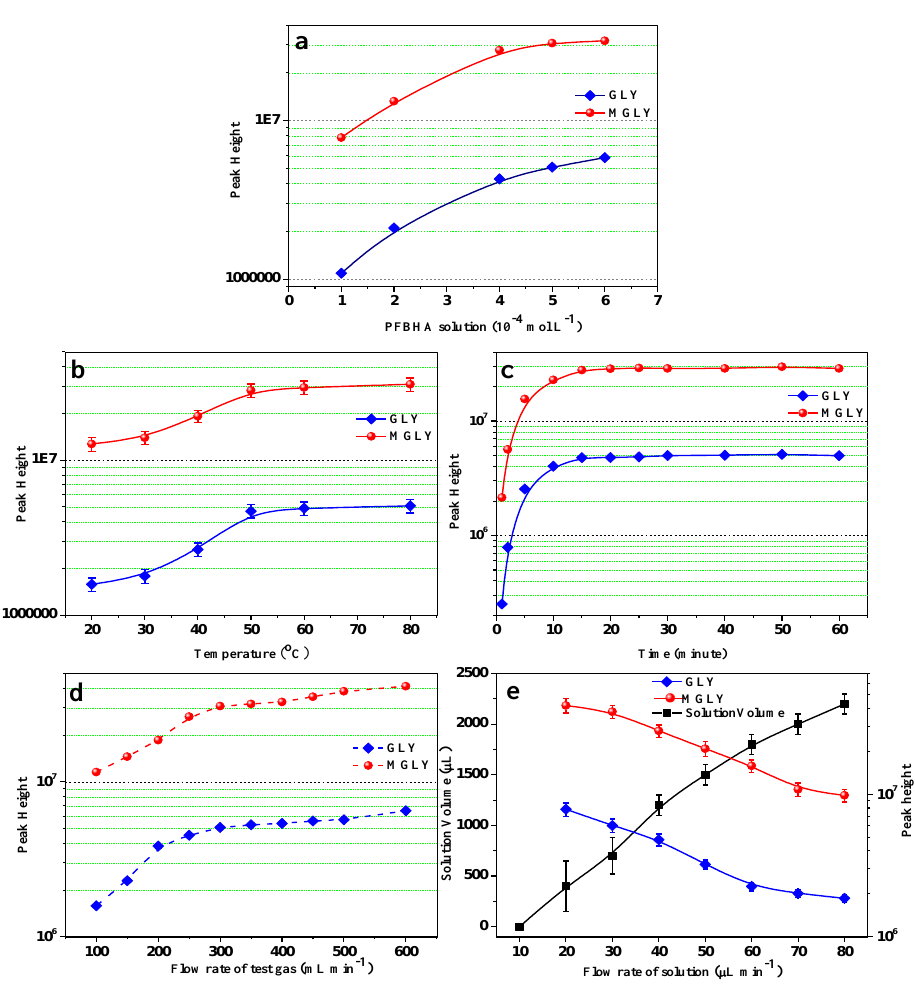
Fig. 3. Influences of PFBHA concentration (a) , temperature of micro-reactor (b) , reaction time (c) , flow rates of GLY and MGLY gas (d) and flow rate of derivatisation solution (e) on the peak heights of derivatives in GC-MS chromatograms. Error bars indicate the relative standard deviations of GC-MS measurements. See text for details of the other experimental